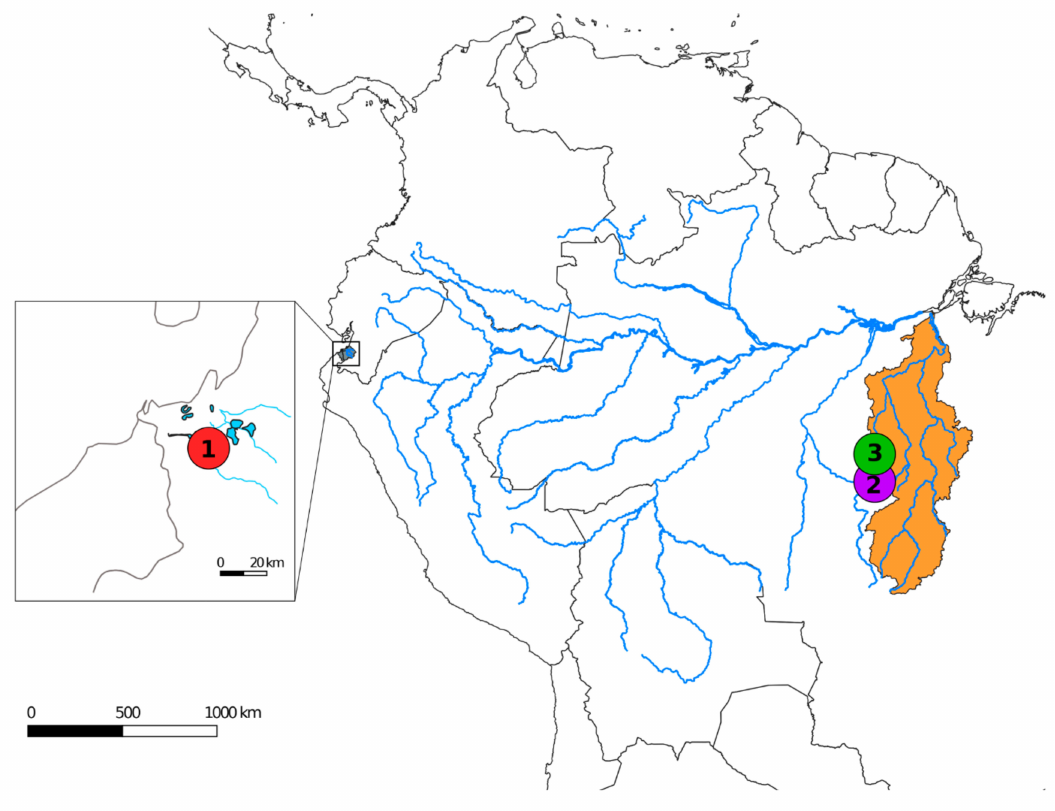
Figure 7. Map of South America highlighting the collection sites of Lebiasina bimaculata (1—red circle) and L. melanoguttata (2—purple and 3—green circles). The maps were created using the following software: QGis 3.4.3, Inkscape 0.92, and Photoshop 7.0.